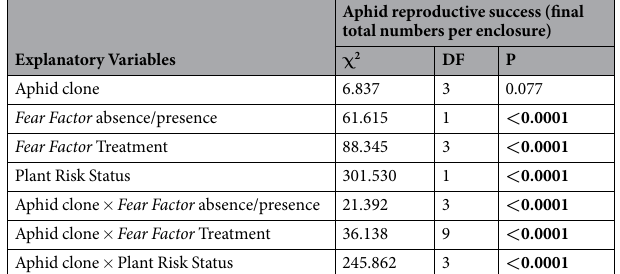
Table 1. Aphid reproductive success in response to Fear Factor . Analysis of Myzus persicae’s reproductive success as function of the absence/presence of Fear Factor (0, 1), ( Fear Factor ) treatments (FF1–FF4), and Plant